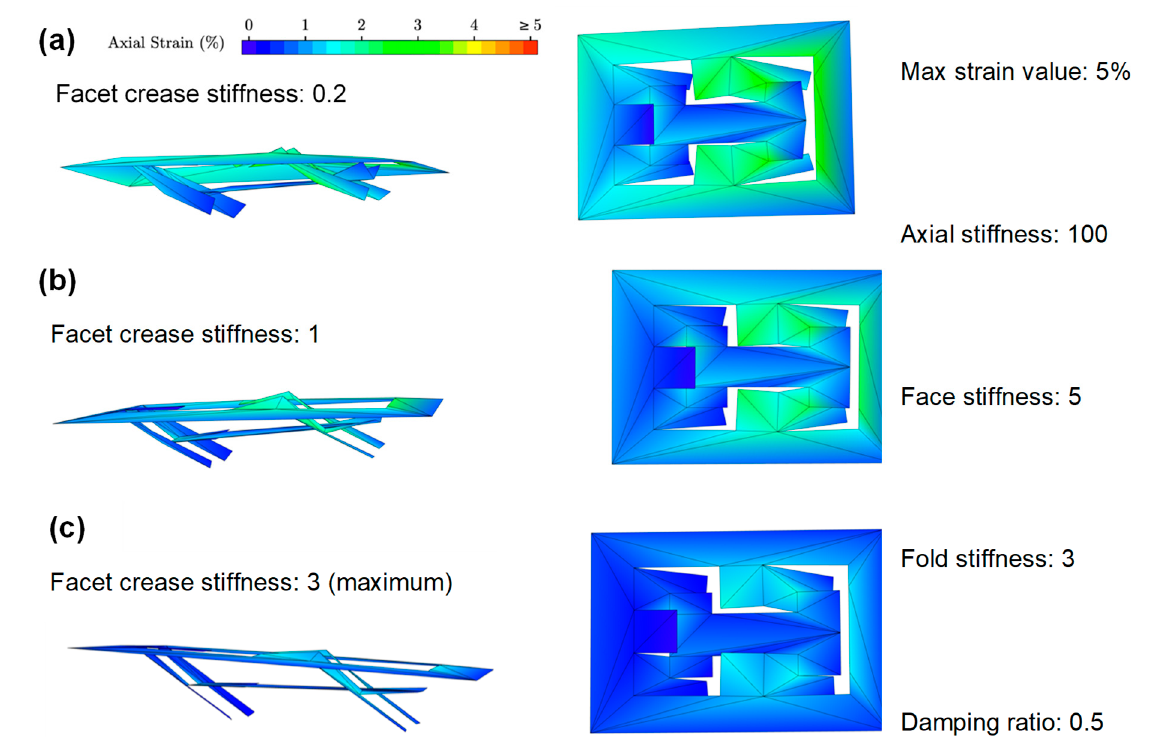
Figure 8. Strain visualization (side view and top view) for SLEM design with increasing facet crease stiffness (the material’s stiffness regarding its predetermined plane). Increasing facet crease stiffness shows an increase in structural rigidity and strength of the material and a decrease in the strain level at joints. Parameter values in the online simulator remain constant: max strain value 5%, maximum axial stiffness, face stiffness, fold stiffness, and damping ratio. The facet crease stiffness values are adjusted to the following values: ( a ) 0.2, ( b ) 1, ( c )